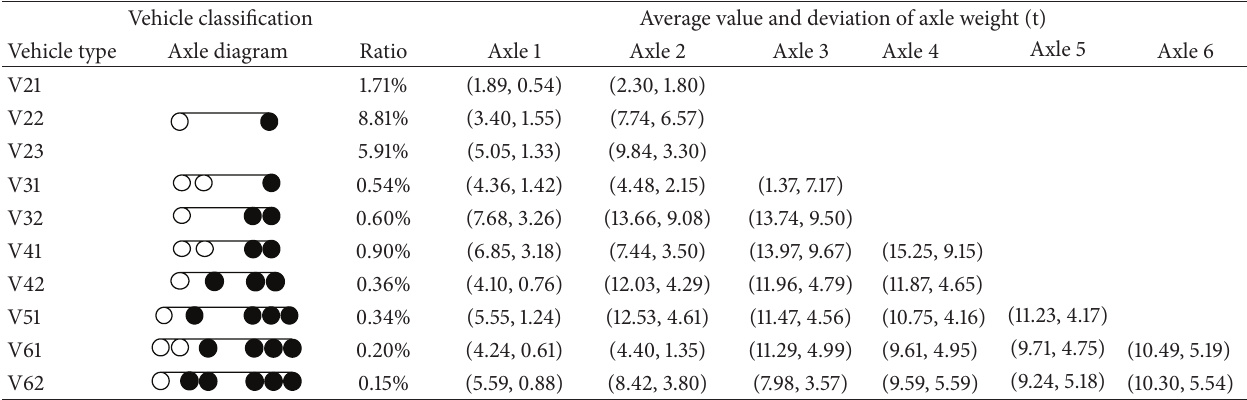
Table 2: Vehicle classification and axle weight statistics.